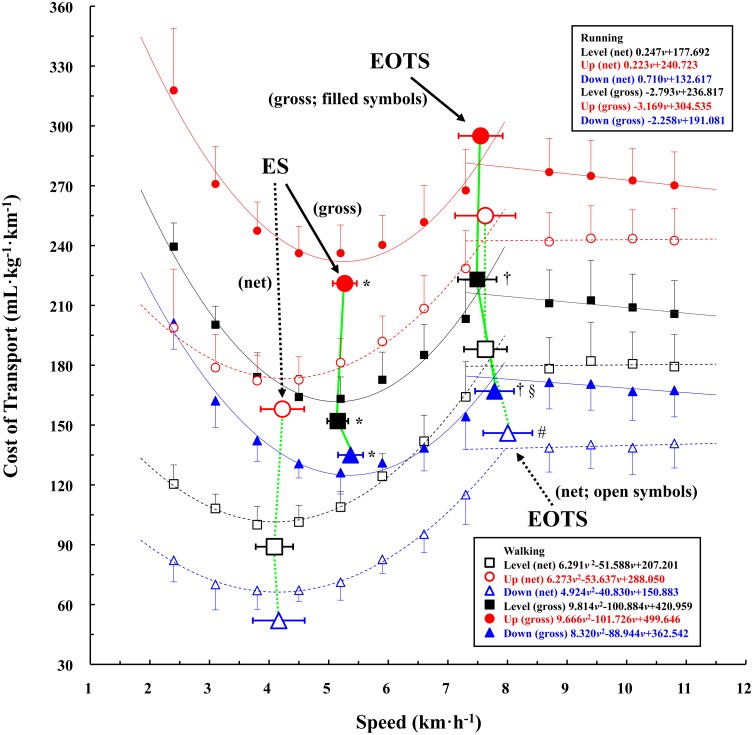
U-shaped and linear cost of transport (CoT) relationships at different gradients.Filled and open symbols show the net and gross CoT, respectively. Circles, squares, and triangles show uphill, level, and downhill gradients, respectively. The mean gross ES, net ES, gross EOTS, and net EOTS are presented. Asterisks (*) indicate ‘gross > net’. Daggers, (†) indicate ‘gross < net’ at the level and downhill gradients. Hash mark (#) indicates ‘faster than the level and uphill gradients’. Section mark (§) indicates ‘faster than level gradient. The ES and EOTS markers were not put based on the correct CoT values, because the markers are likely to overlap with the CoT plots and regression lines. Data are mean ± SD.